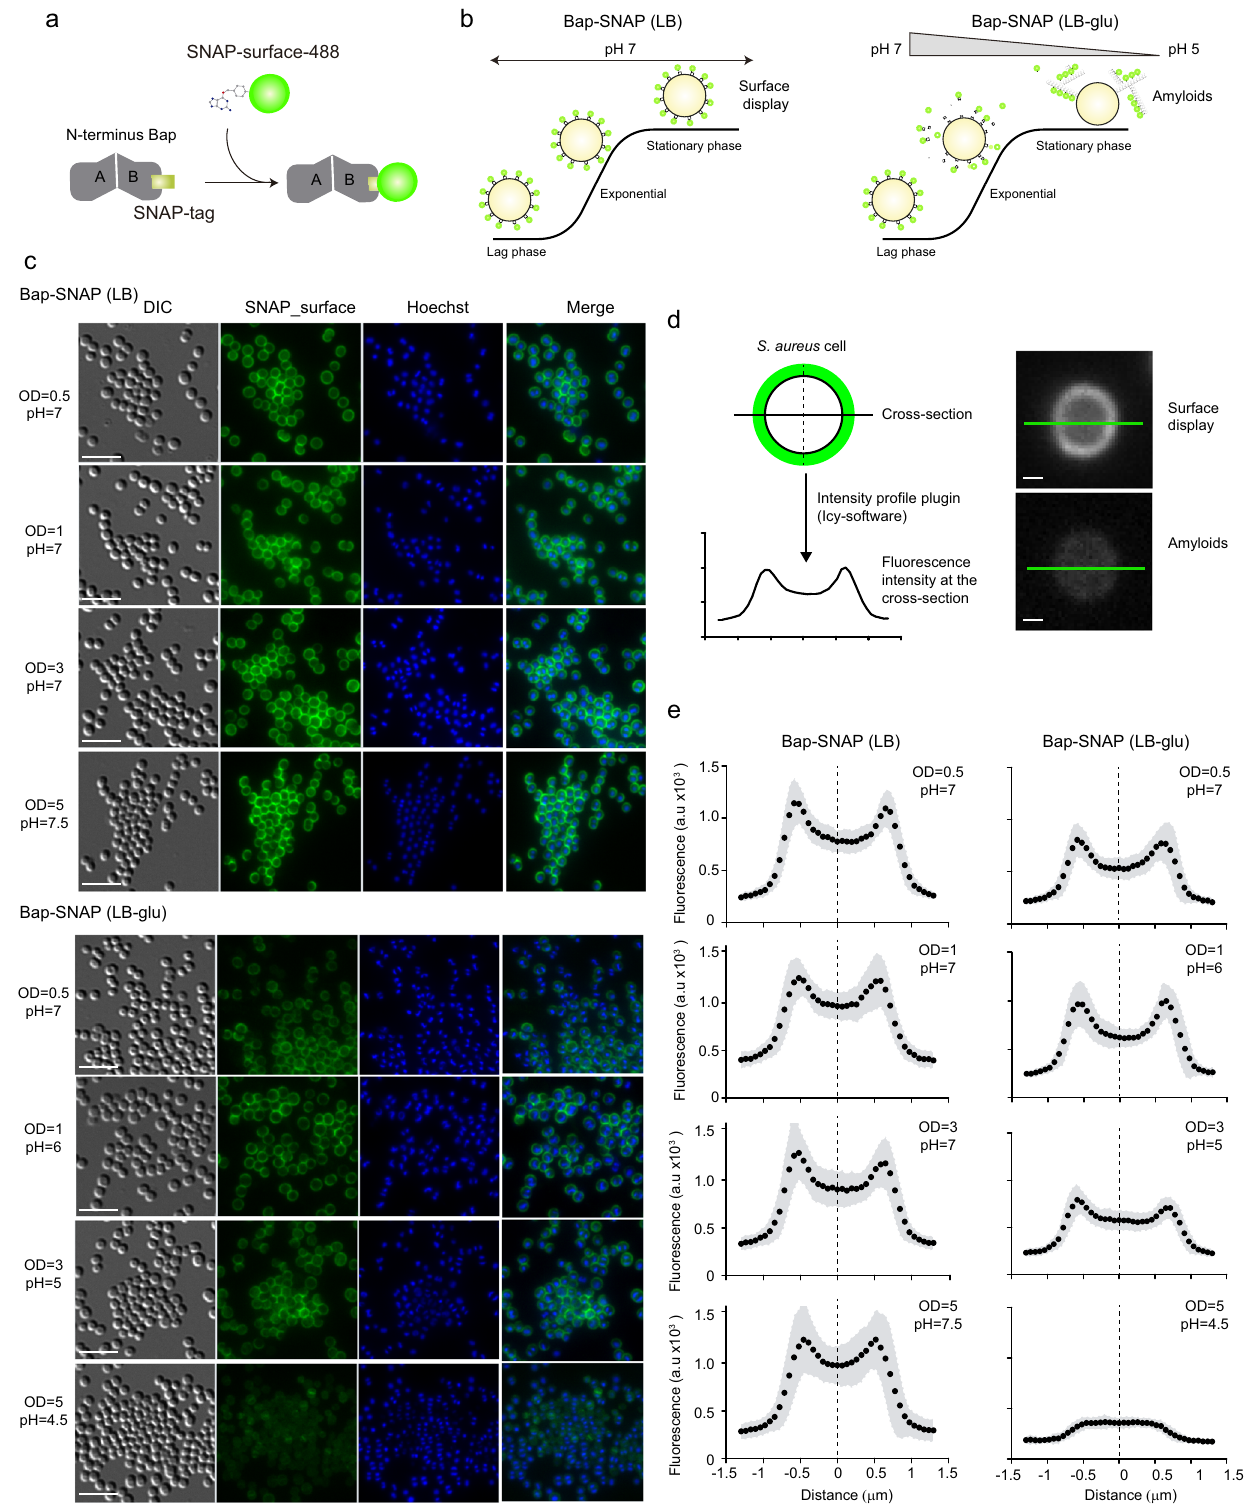
using the Intensity Pro fi le plugin (Fig. 5c). As a negative control, S. aureus Bap-Spy cells were incubated with puri fi ed untagged